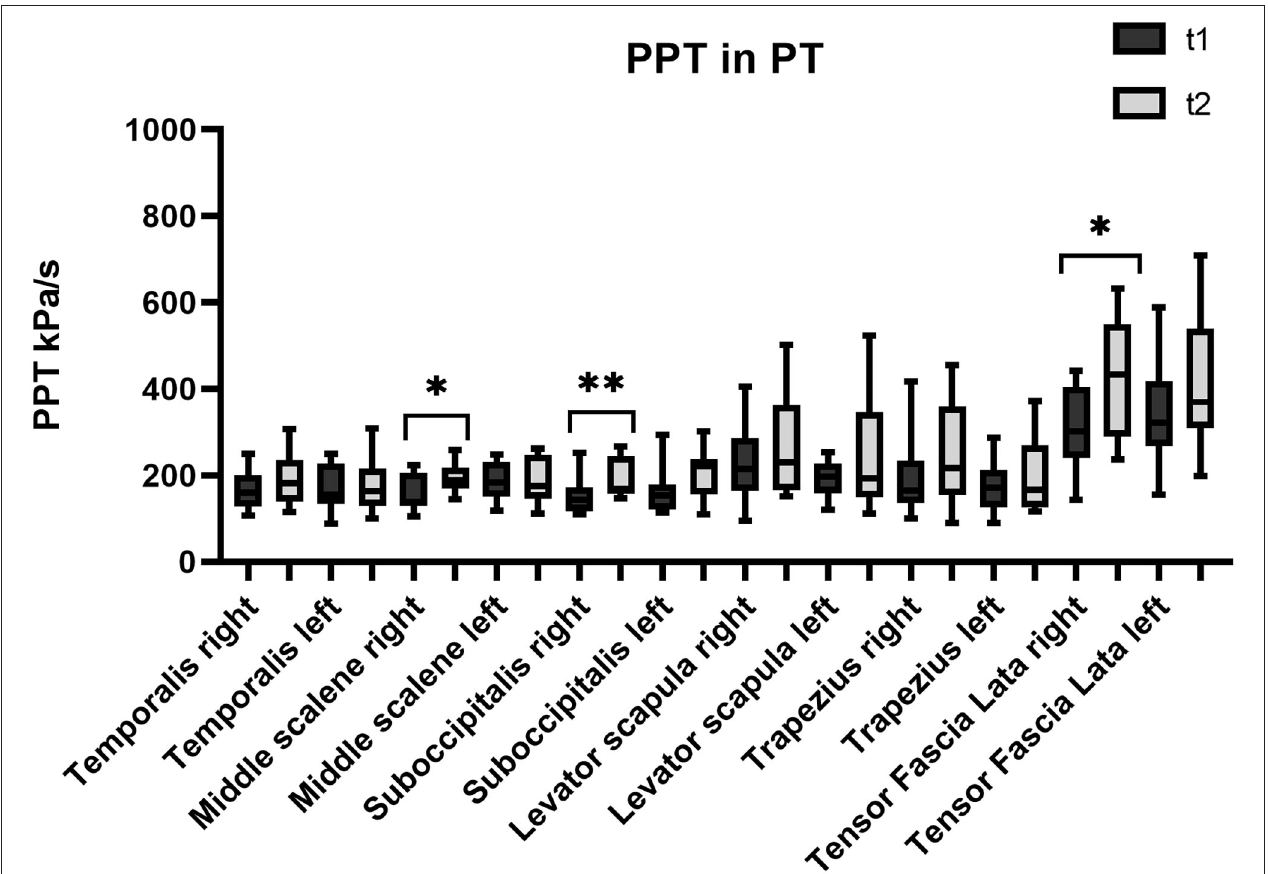
FIGURE 3 | Pressure pain threshold over the trigeminal and extra-trigeminal area before (T1) and after (T2) physical therapy (PT)